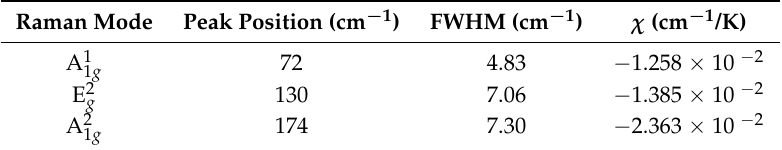
Table 1. Comparison of the Raman peak position, FWHM, and temperature coefficient for different Raman modes in the large Bi 2 Se 3 hexagonal single-crystal nanoplates.